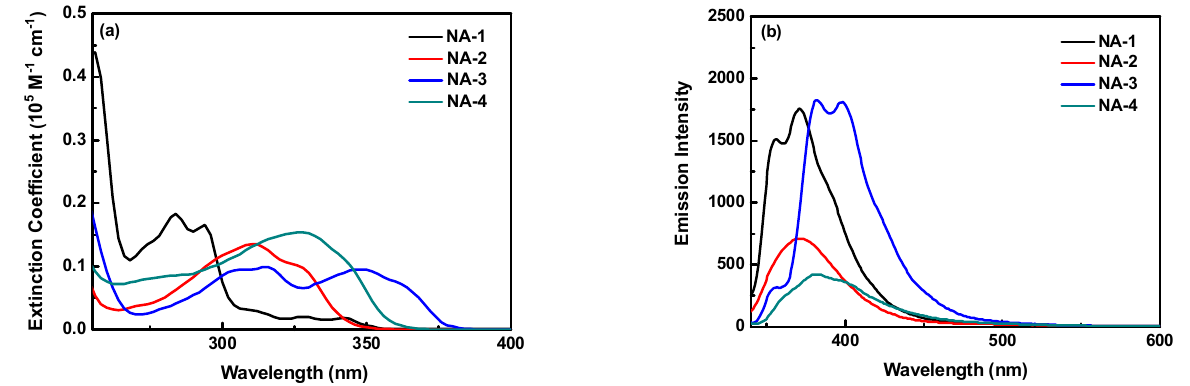
Figure 1. ( a ) UV − vis and ( b ) PL spectra of NA-1–4 in CH 2 Cl 2 solution (concentration = 1 × 10 − 5 M). Table 1. Electrooptical parameters and thermal properties of the compounds. Sample